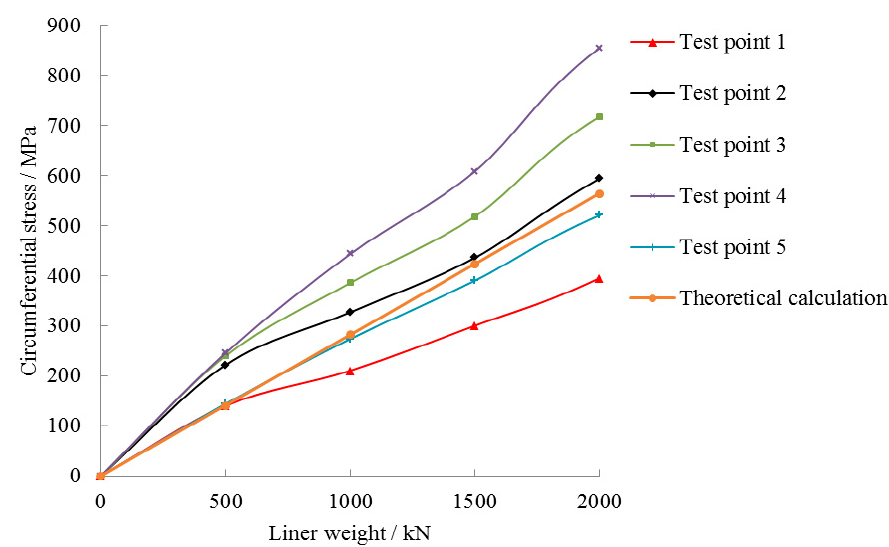
Figure 13. Comparison of theoretical calculation and test results.